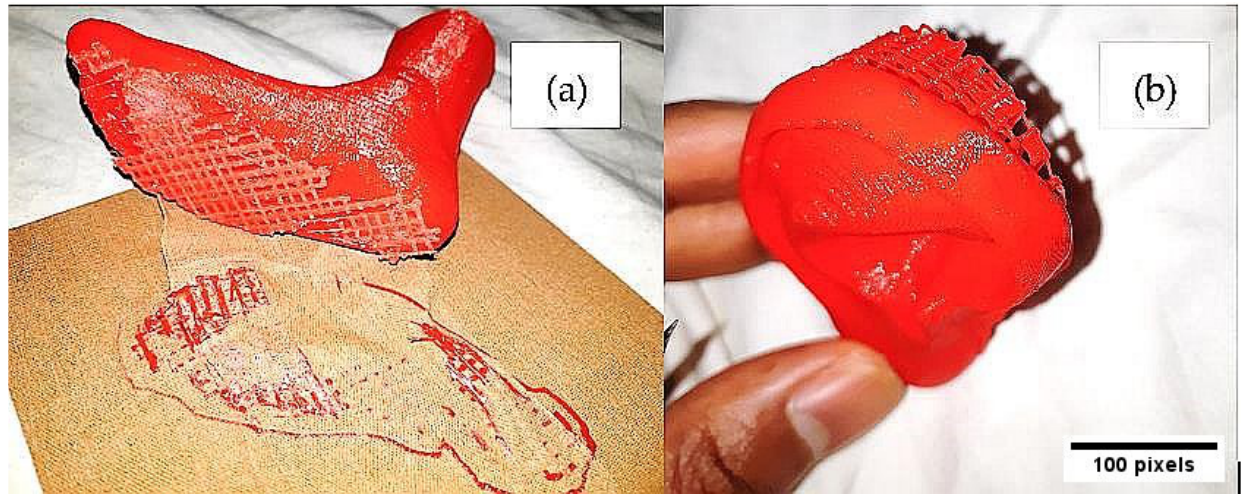
Figure 4. Illustration of overhangs: ( a ) human foot with a support structure; ( b ) human outer ear with a support structure.